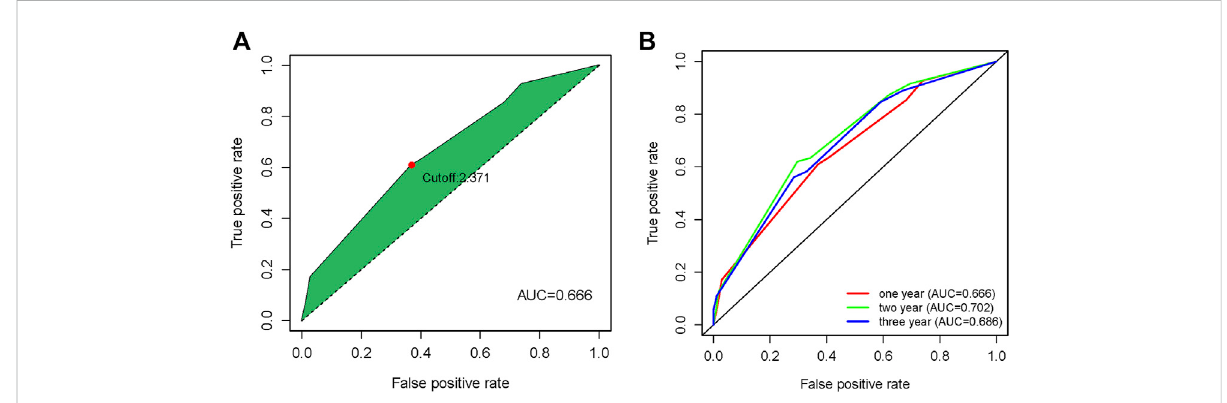
FIGURE 4 TimeROCcurvesonoverallsurvivalpredictionintheGSE53625cohort (A) TimeROCcurveswithcutoffvalue, (B) TimeROCcurvesatoneyear, two year and three year.